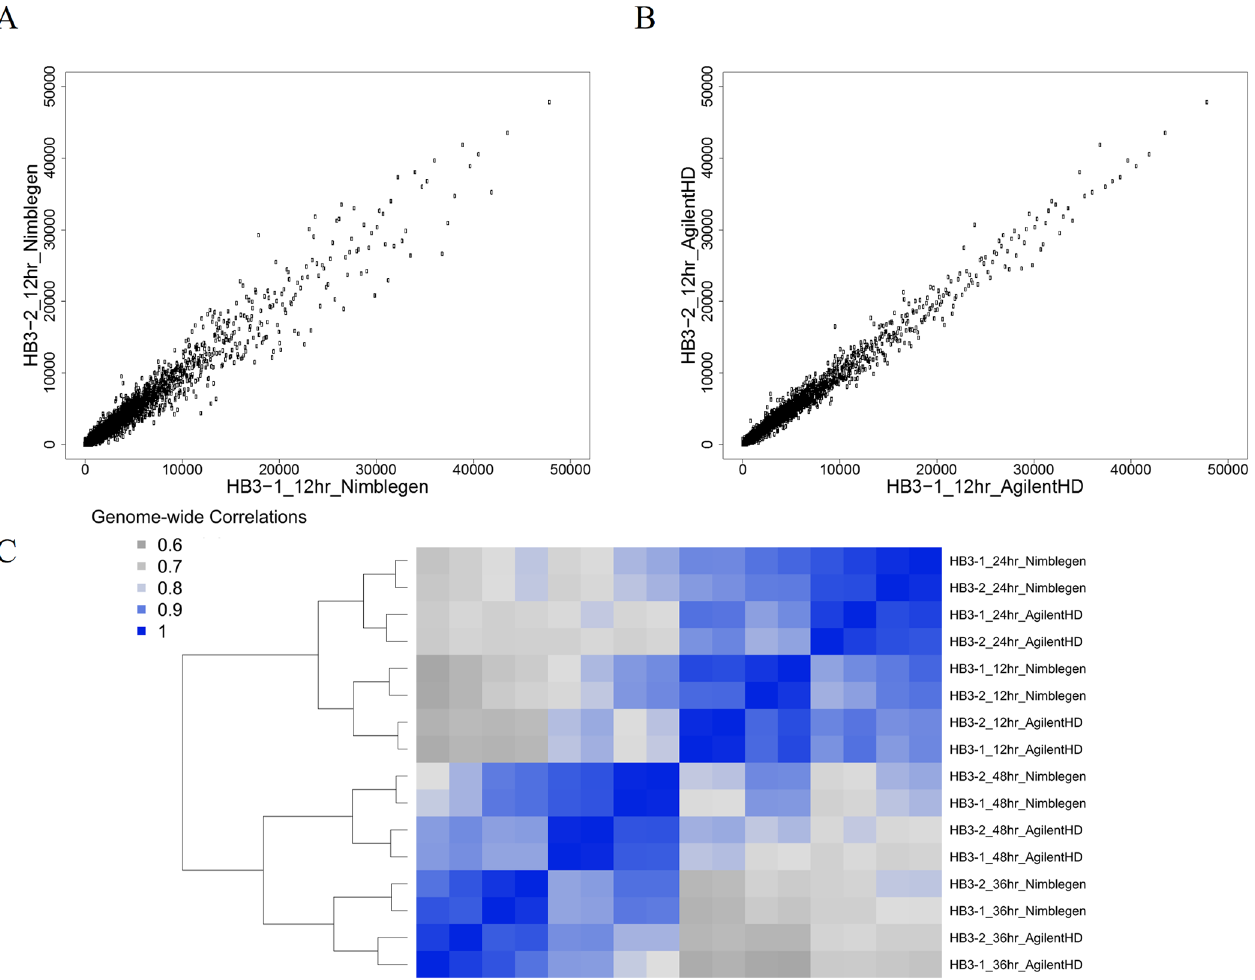
Fig 1. Biological replicates show high reproducibility on the exon arrays. Spearman correlationsof biological replicates show highly reproducible signal for 12 hpi sampleshybridizedto the (A) Nimblegenand (B) Agilent HD exon arrays. (C) Hierarchical clusteringof correlation values across all samples hybridizedto the high-densityexon arrays show reproducibility of signalbetween chip platforms across the intra- erythrocytic lifecycle.